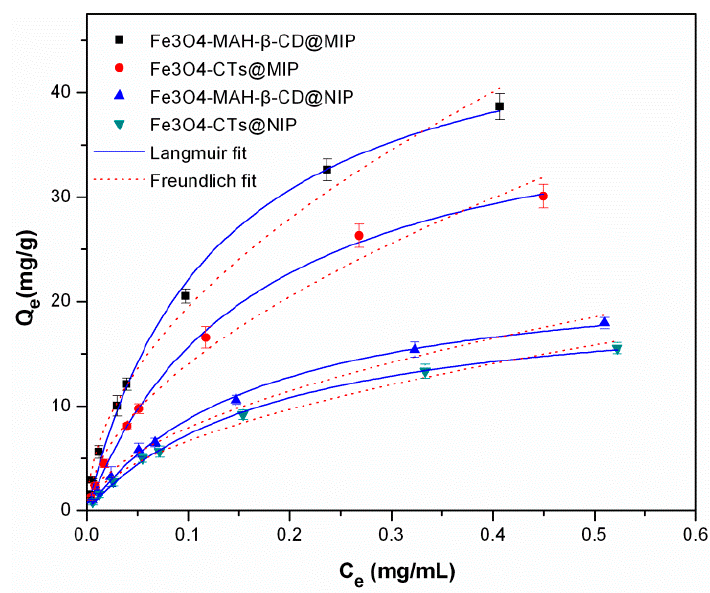
Figure 8. Adsorption isotherms of 2-aminopyridine on Fe 3 O 4 -CTs@MIP, Fe 3 O 4 -CTs@NIP, Fe 3 O 4 -MAH- β -CD@MIP and Fe 3 O 4 -MAH- β -CD@NIP at 298 K. (mean ± SD, n = 3).